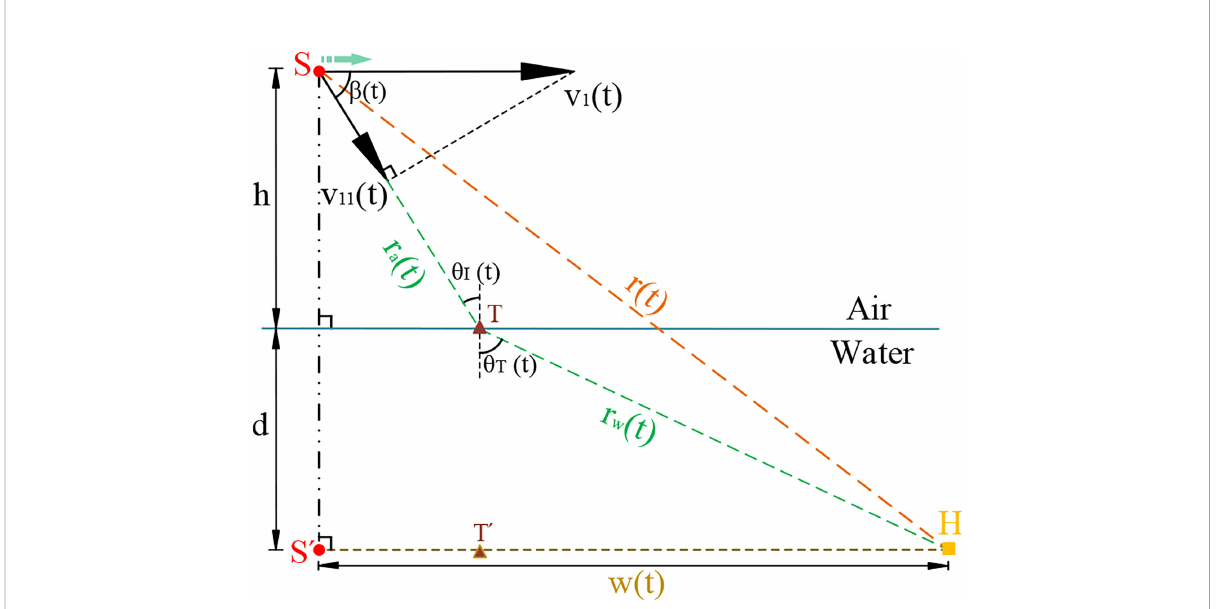
FIGURE 3 Vertical plane of a direct ray path from source to the hydrophone. Refraction of a ray with a speci fi c incidence angle q I ( t ) through an air – water- layered environment at point T